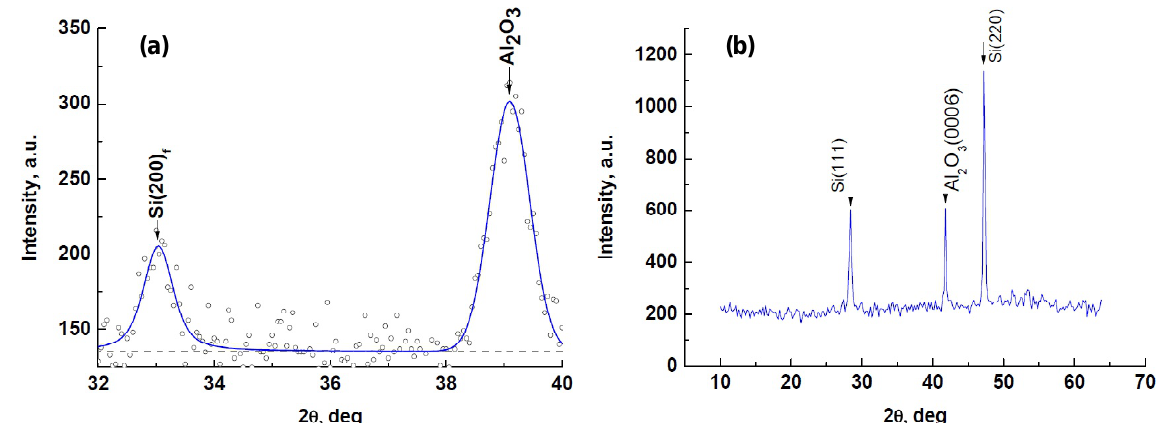
Fig. 3. X-ray diffractograms of the initial layers of Si(100) and Si(111) grown on Al of the Si(100)/r-plane Al O structure on Fab-2-R-plane and Fab-1-R-plane; (b) diffractogram of the Si (111)/ 2 3 c-plane Al O structure on Fab-2-C-plane 2 3